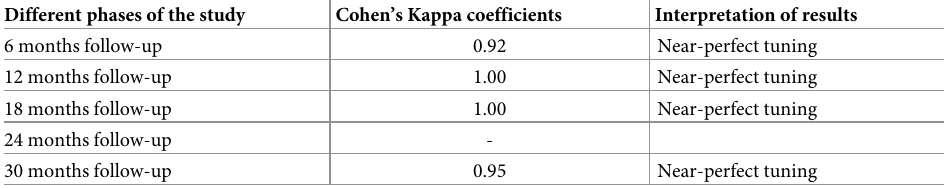
Table 4. Summary results of the different levels of concordance between rapid HIV screening tests performed in the field by biomedical laboratory technicians and quality assurance control at the national reference laboratory for each of the 5 phases of cohort follow-up, Benin